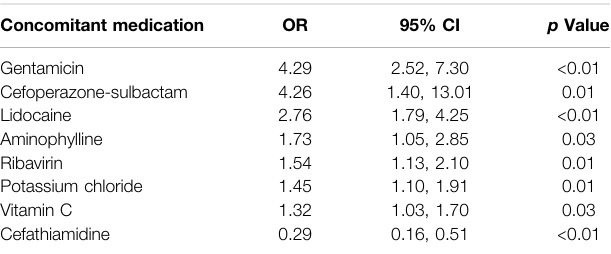
TABLE 4 | Multivariable conditional logistic regression analysis